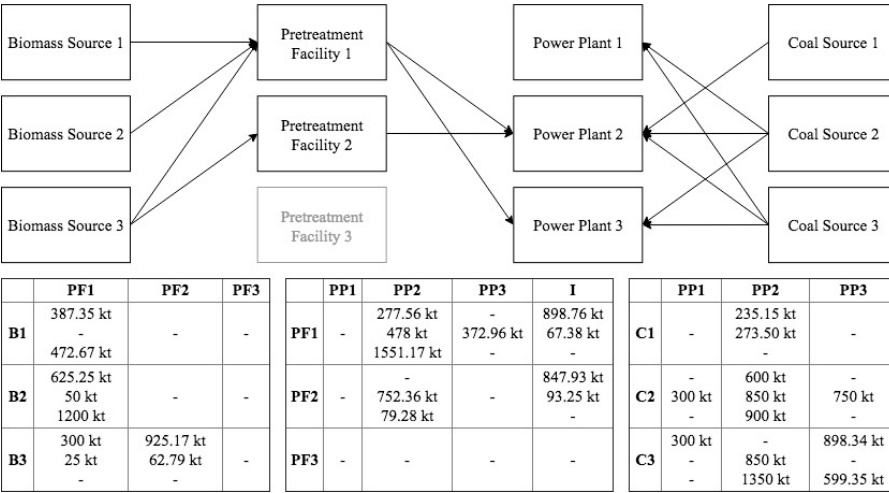
Figure 10. Optimal Network for Worse Biomass Properties in Period 2. Energies 2019 , 12 , x FOR PEER REVIEW